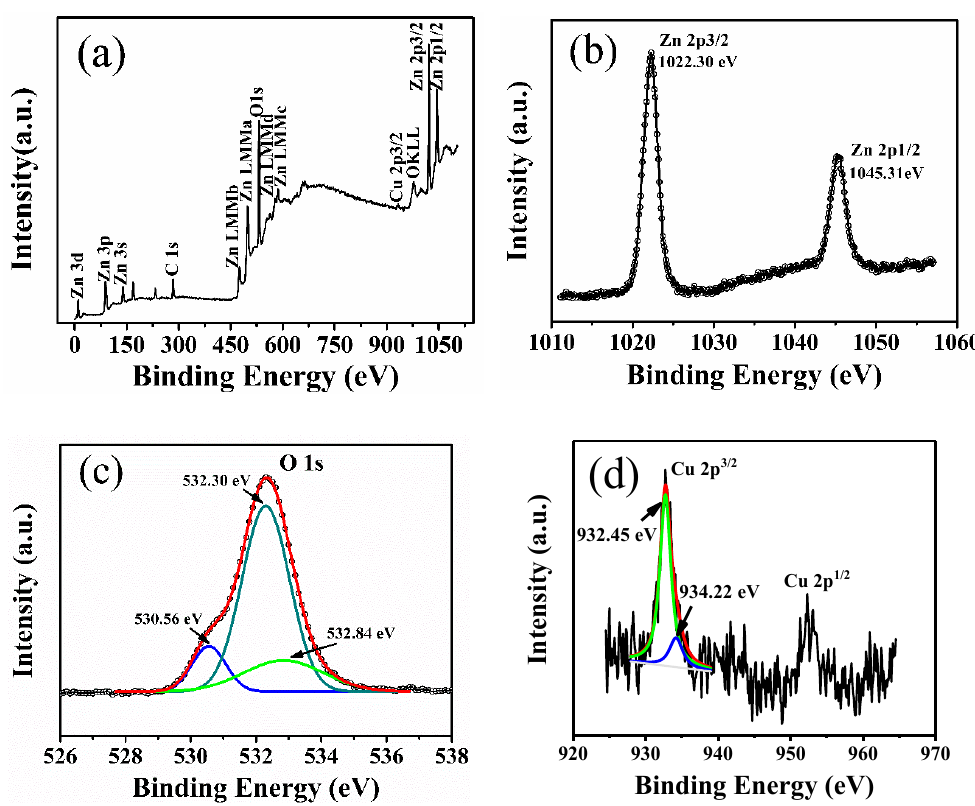
Figure 5. XPS spectra of lightly Cu-doped ZnO (0.25%) nanocrystals: ( a ) Wide-scan spectrum; ( b – d ) the corresponding narrow-scan spectra of Zn 2 p , O 1 s , and Cu 2 p , respectively. Peak positions are referenced to the adventitious C 1 s peak taken to be at 284.6 eV.